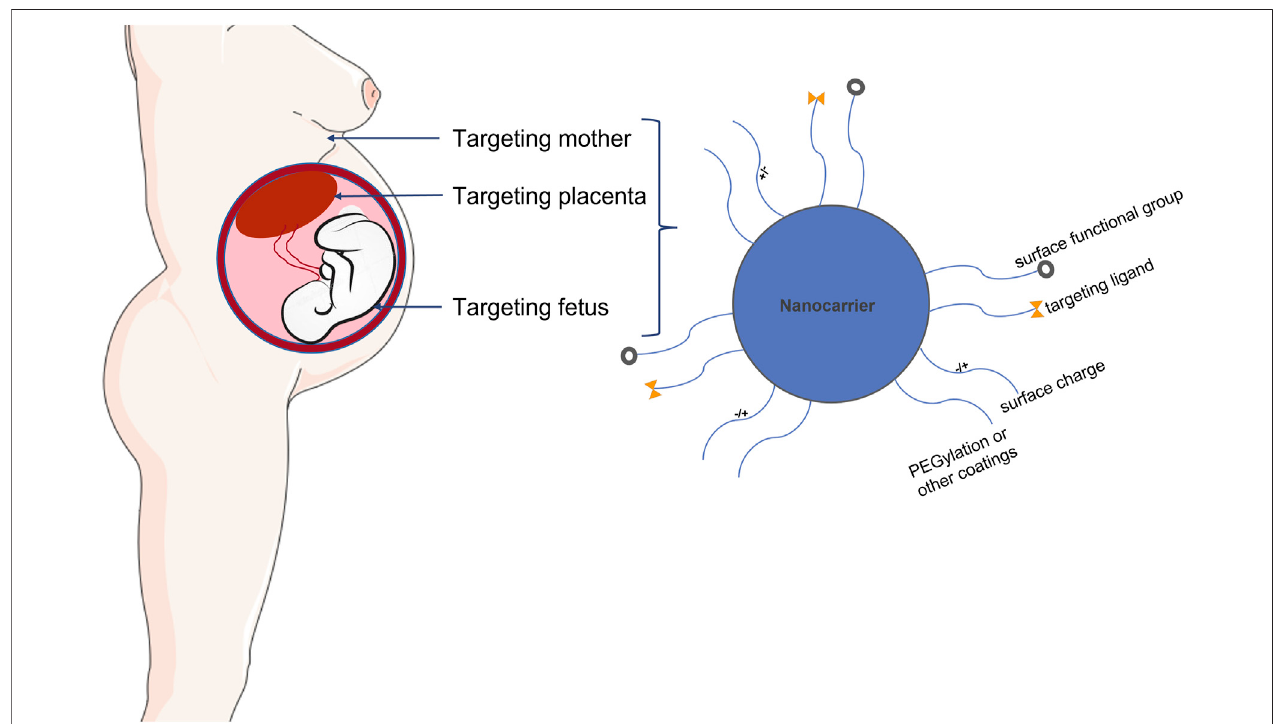
FIGURE 5 | Schematic illustration demonstrating placental targeted drug delivery and nanoparticles applied in pregnancy. Nanoparticle mediated controlled drug and gene delivery speci fi cally targeted to placenta may provide novel avenues for treating placental dysfunction without potential side effects.